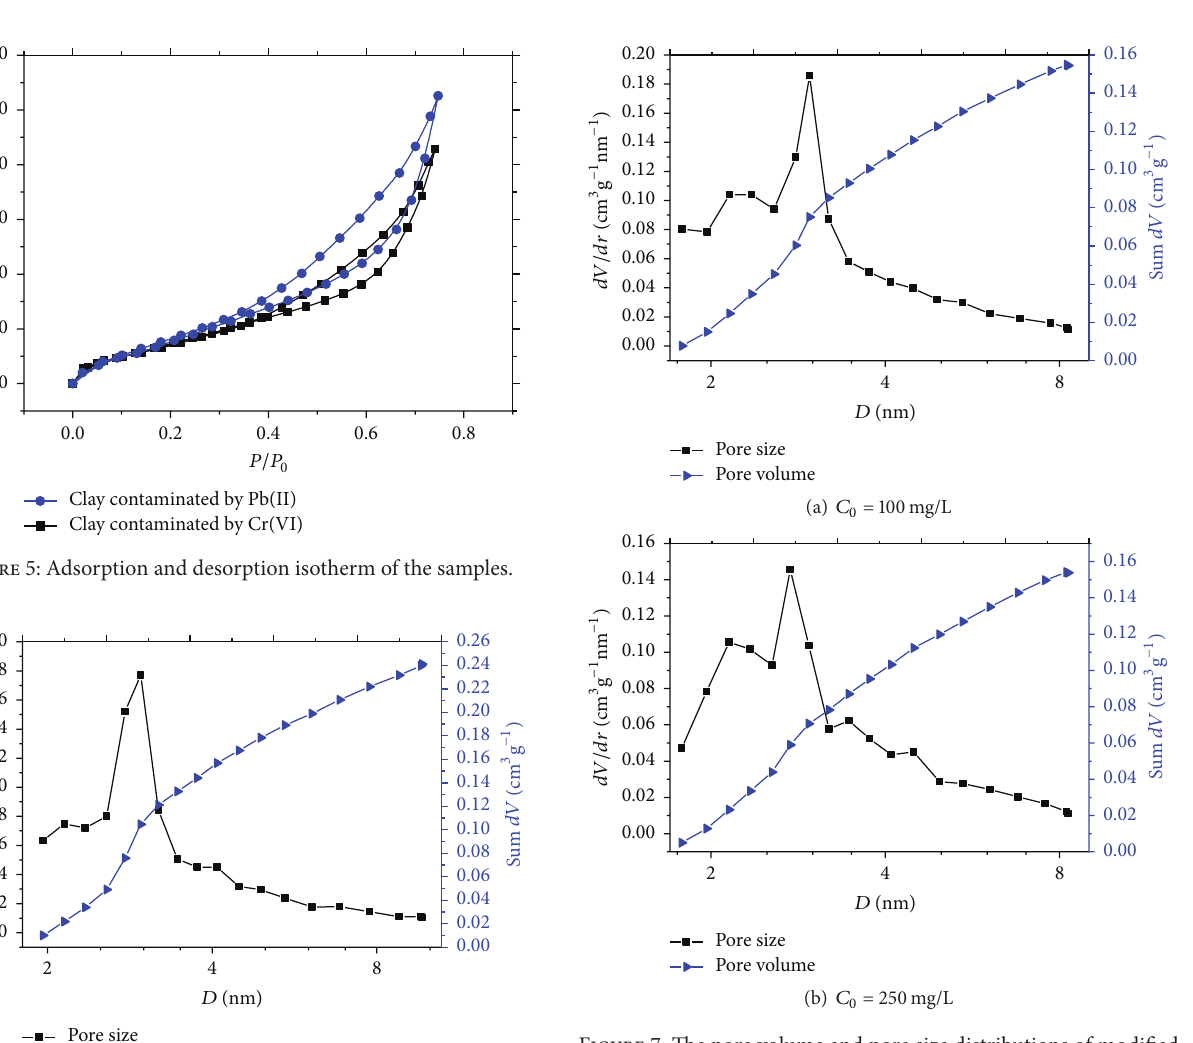
Figure 7: The pore volume and pore size distributions of modified clay after absorbing